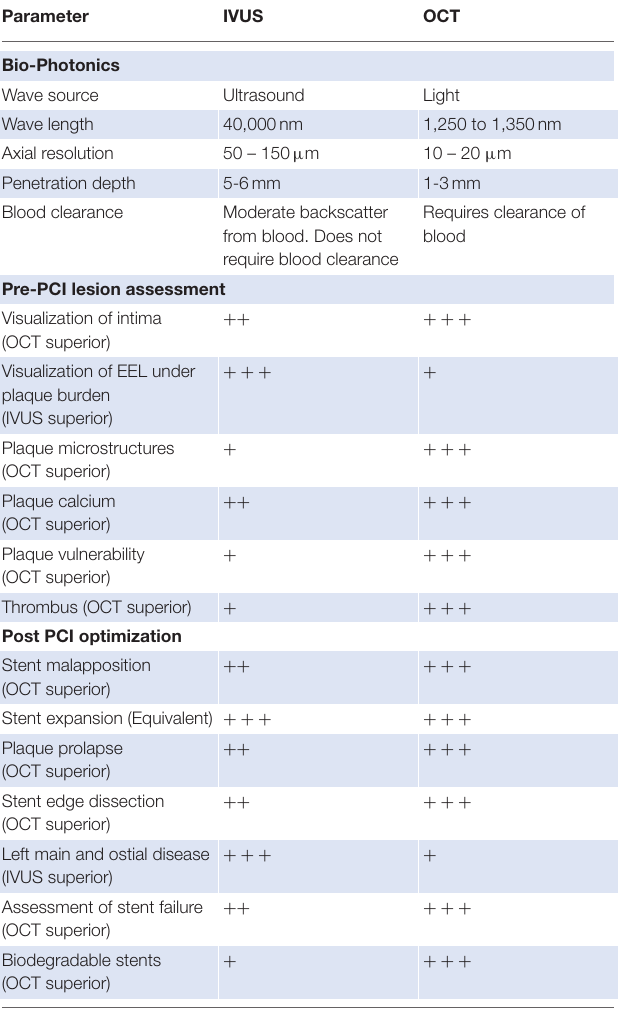
TABLE 1 | Comparison between intravascular ultrasound (IVUS) and optical coherence tomography